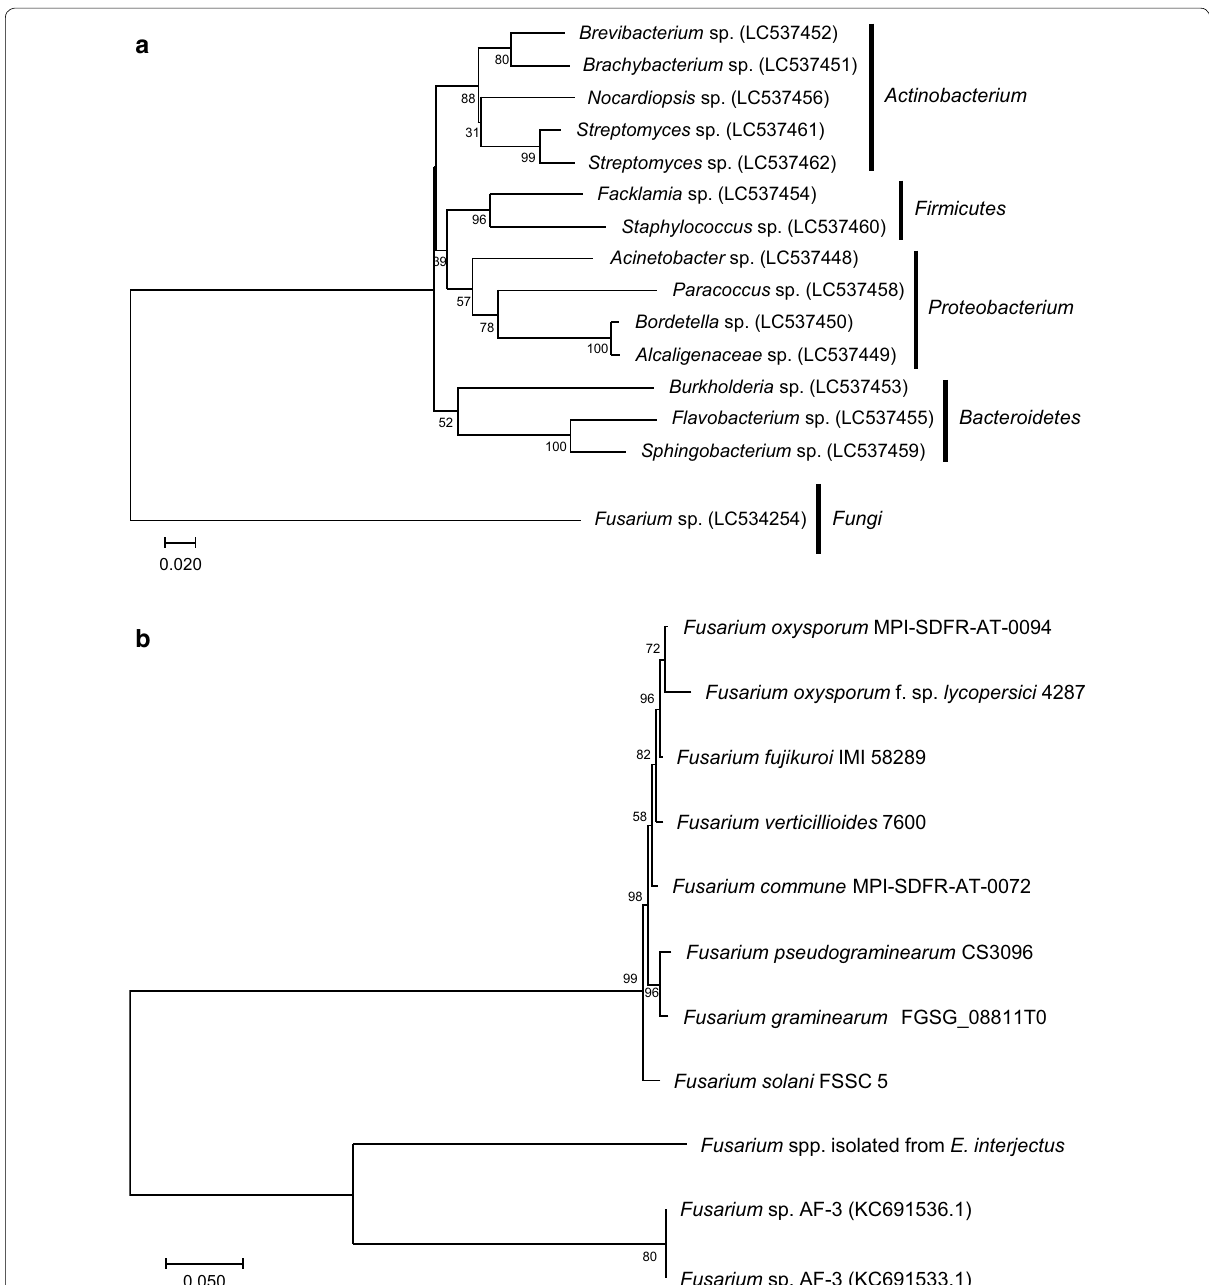
Fig. 2 Phylogenetic tree analysis of DGGE profiles of Fusarium isolated from Ficus tree tunnel. a Phylogenetic tree of 16S rRNA and 18S rRNA gene sequences obtained from DGGE analysis. The 16S rRNA gene sequences of the bacteria and the 18S rRNA gene sequence of the fungus in the excavated tunnel by E. interjectus were registered in the GenBank database under Accession numbers LC537448 to LC537462, and LC534254, respectively. The microbial DNA sequences were identified using the NCBI database. b Phylogenetic tree of the partial EF - 1α gene sequences of Fusarium spp. isolated from a tunnel in a Ficus tree excavated by E. interjectus , various Fusarium species registered in the JGI database (https :// mycoc osm.jgi.doe.gov/Fusar ium/Fusar ium.info.html), and Fusarium sp. AF-3 in the NCBI database. EF - 1α genes of KC691533.1 from Fusarium sp. AF-3, KC691536.1 from Fusarium sp. AF-3, 599354 from F. commune MPI-SDFR-AT-0072, 8475 from F. fujikuroi IMI 58289, 9400 from F. graminearum FGSG_08811T0, 17733 from F. oxysporum f. sp. lycopersici 4287, 554906 from F. oxysporum MPI-SDFR-AT-0094, 4767 from F. pseudograminearum CS3096, 485664 from F. solani FSSC 5, 10379 from F. verticillioides 7600, and LC534255 from Fusarium spp. strain EI are shown. The phylogenetic